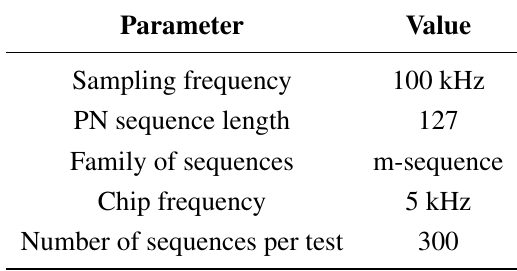
Table 2. Configuration parameters and setup for the wideband sounding in the 2013 to 2014